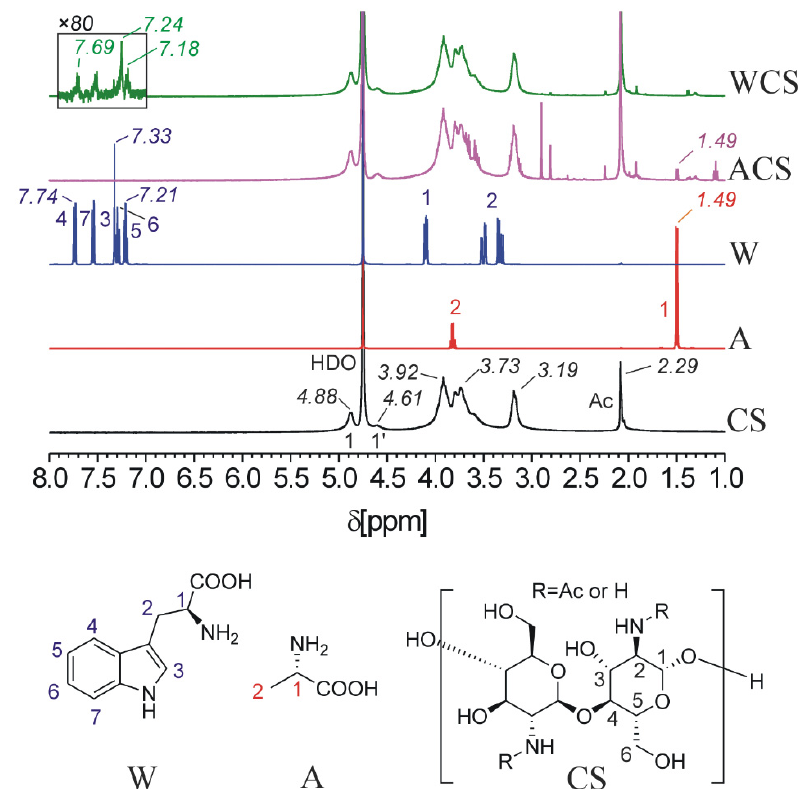
Figure 3. 1 H-NMR spectra of CS, A, W, ACS and WCS (303 K, 1% CD 3 COOD in D 2 O). Signal assignment is given using color-coded numbers. Positions at acetylated unit of CS are denoted by an apostrophe.